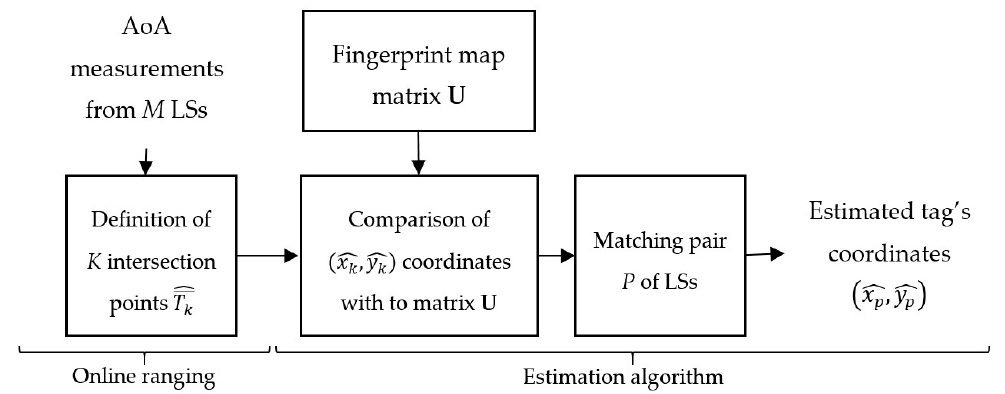
Figure 5. Online synthesis block diagram.